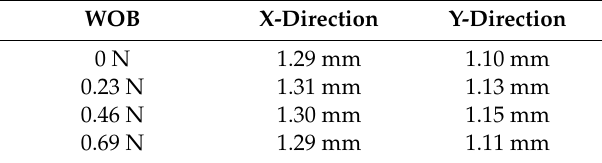
Table 11. Lateral displacement of BHA under di ff erent WOB in experiment.